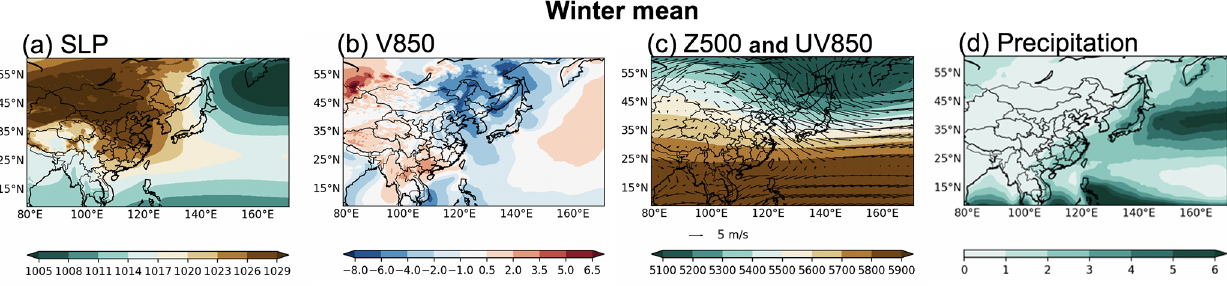
Figure 3. Winter mean (a) sea level pressure (SLP; hPa), (b) 850hPa meridional wind (V850; ms − 1 ), (c) 500hPa geopotential height (Z500; m, green and brown shading) and 850hPa wind (arrows), and (d) precipitation (mmd − 1 ) during DJF 2013–2017.